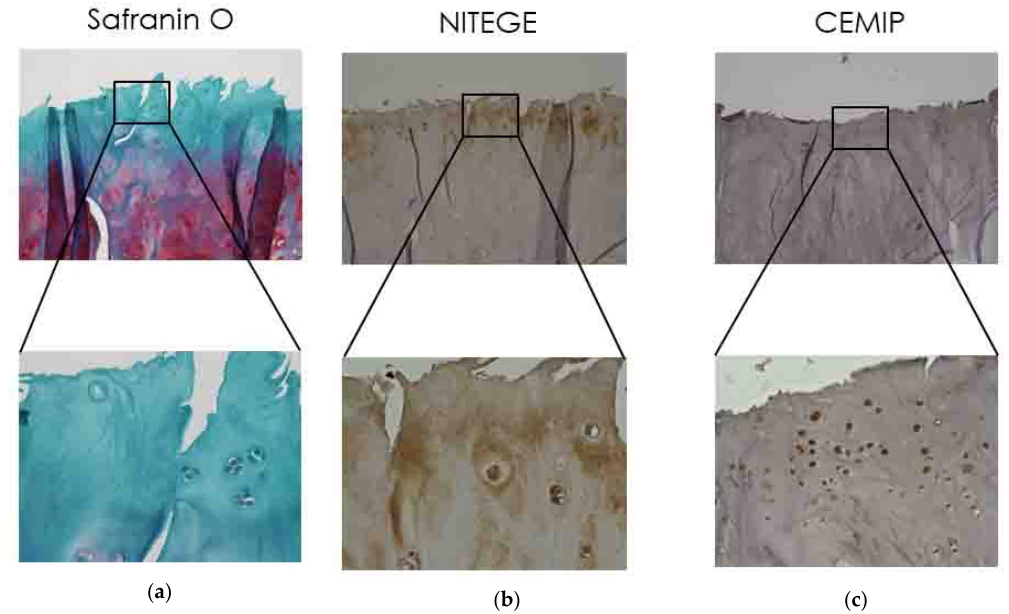
Figure 1. CEMIP expression was examined in OA cartilage. Serial sections of OA cartilage samples were subjected to Safranin O staining ( a ), immunostaining with antibodies to NITEGE ( b ), and CEMIP ( c ). Areas with severe OA show weak staining with Safranin O ( a ). Strong NITEGE-immunostaining was shown in damaged areas in OA cartilage ( b ). CEMIP-positive chondrocytes were located in the NITEGE-positive area of OA cartilage ( c ). The boxed areas in the top are shown at higher magnification at the